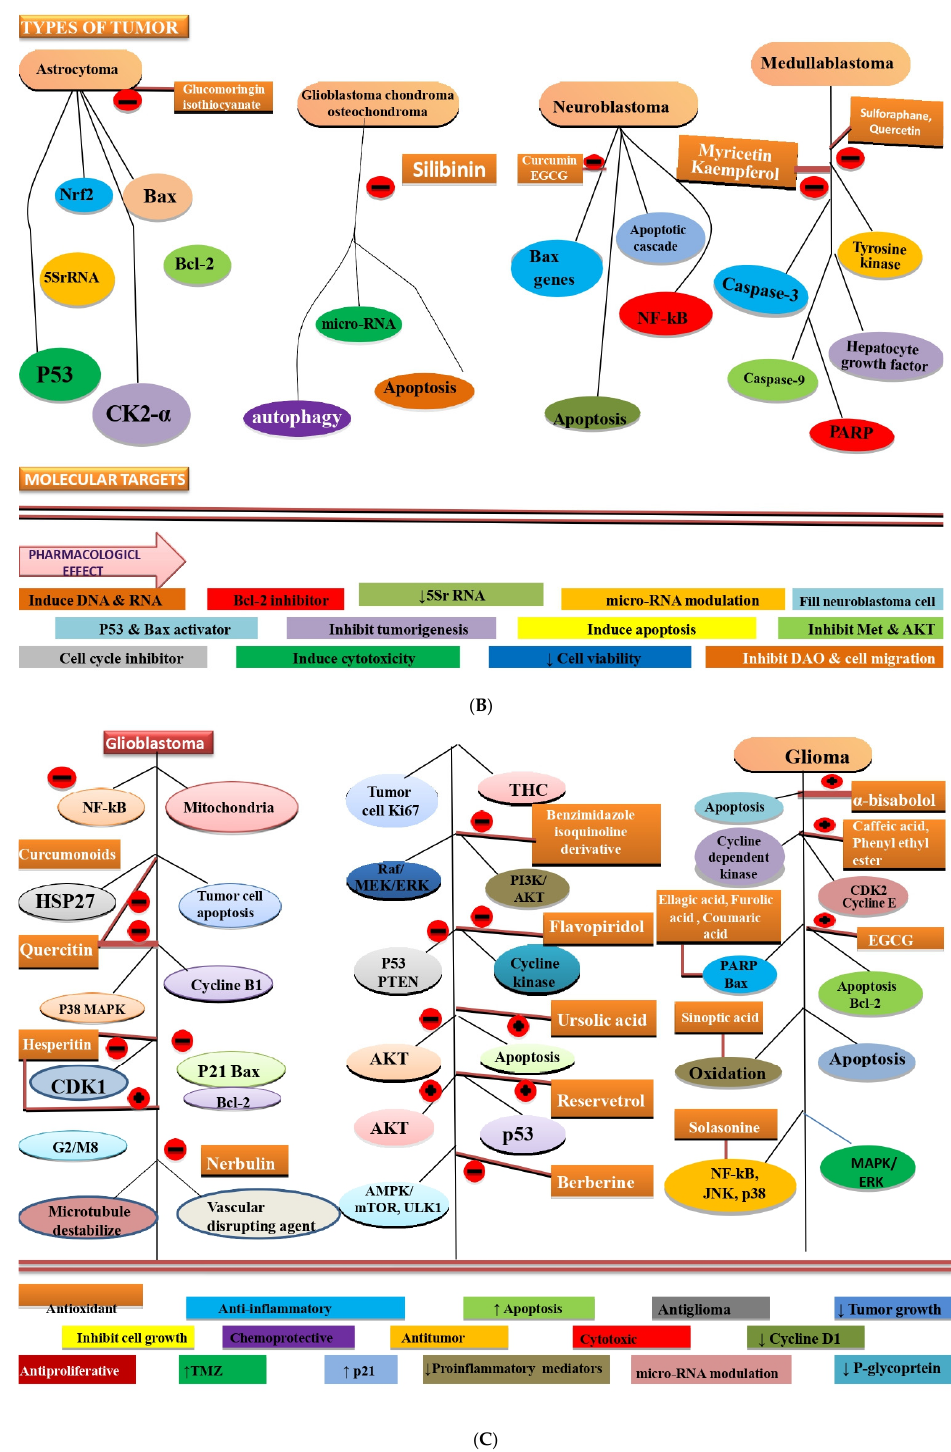
Figure 2. ( A – C ) Flowchart showing the specific effect of various phytochemicals on the different types of benign (meningioma, chondroma, pituitary, schwannoma) and malignant tumours (astrocytoma, glioblastoma, chordoma, neuroblastoma, medulloblastoma, osteochondroma) along with their cellular/molecular targets resulting in a plethora of protective mechanisms against tumours.